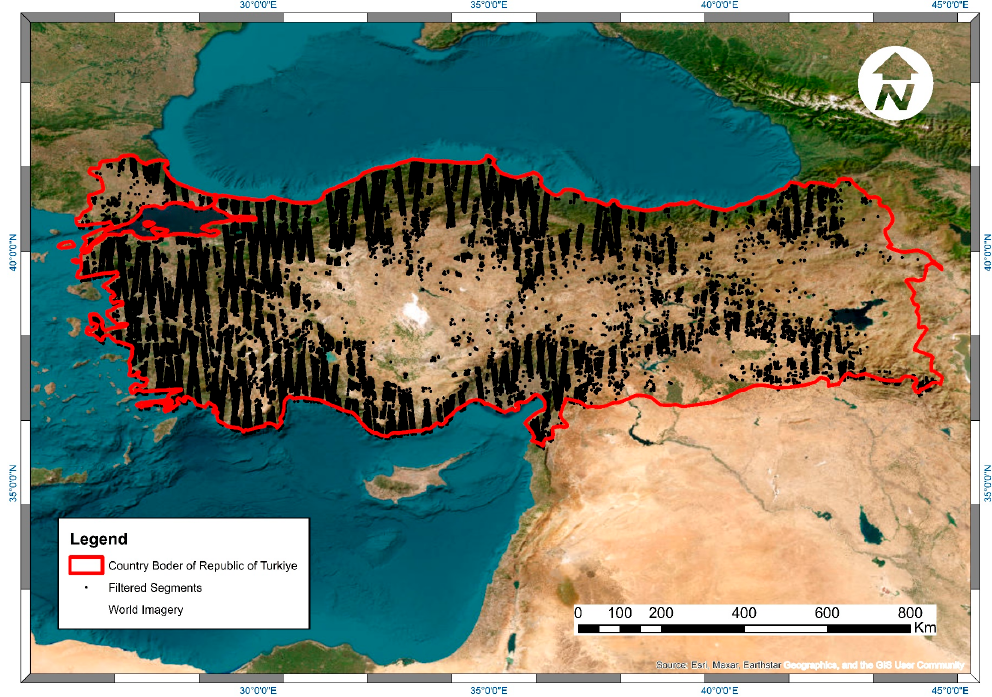
Table 2. Canopy cover classes based on Turkish forest management practices [52].